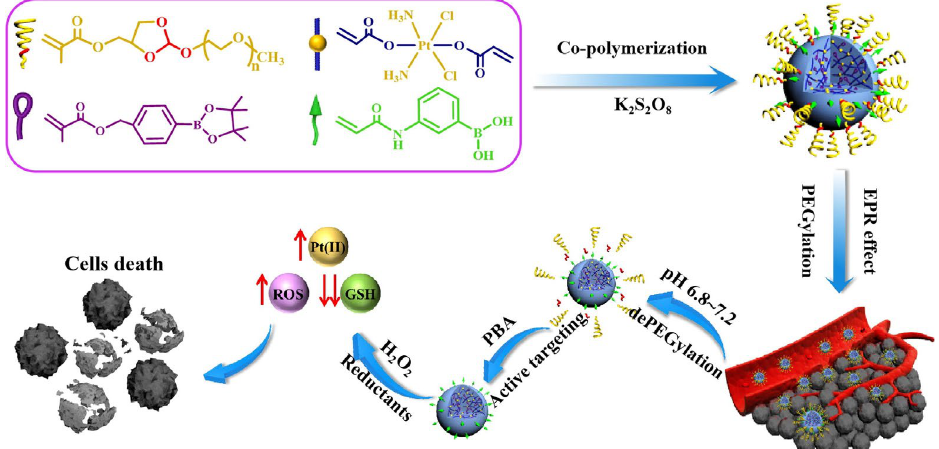
Figure 5. Schematic illustration of the copolymerization of four functional monomers to obtain the dynamic PEG-modified nanogels, and their pH-sensitive “tumor-triggered targeting” and com- bined cancer therapy. Reprinted with permission from Ref. [97]; Elsevier.